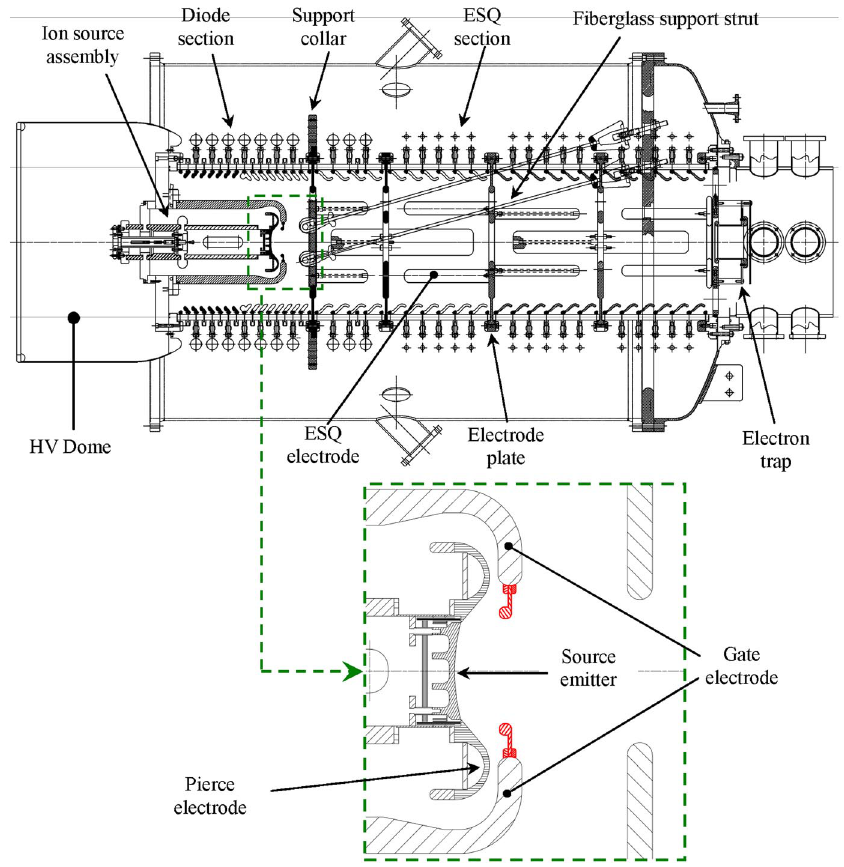
FIG. 2. (Color) 2-MV injector accelerator column showing fiberglass support struts. The column length is 2.4 m. The red part in the inset shows the addition to the gate electrode reducing its aperture diameter from 179.5 to 110